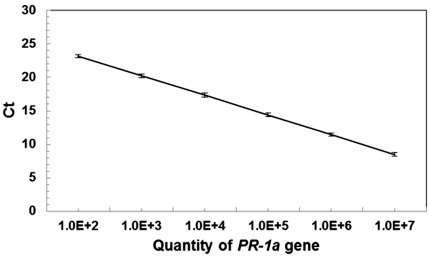
Standard curves for the PR-1a gene obtained in real-time PCR assays.Ct values represent the mean of 10 measurements and are shown on the y-axis, whereas differential concentrations are shown on the x-axis. Error bars represent standard deviation (SD).